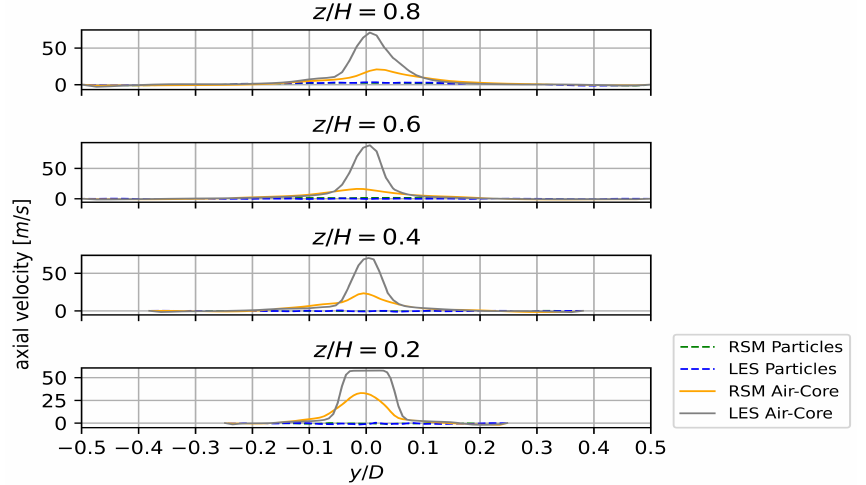
Figure 15. Axial velocities (m/s) as a function of the normalised y co-ordinate at various heights at flow-time 4 s for the simulations with the particles included and at flow-time 2 s for the air-core only